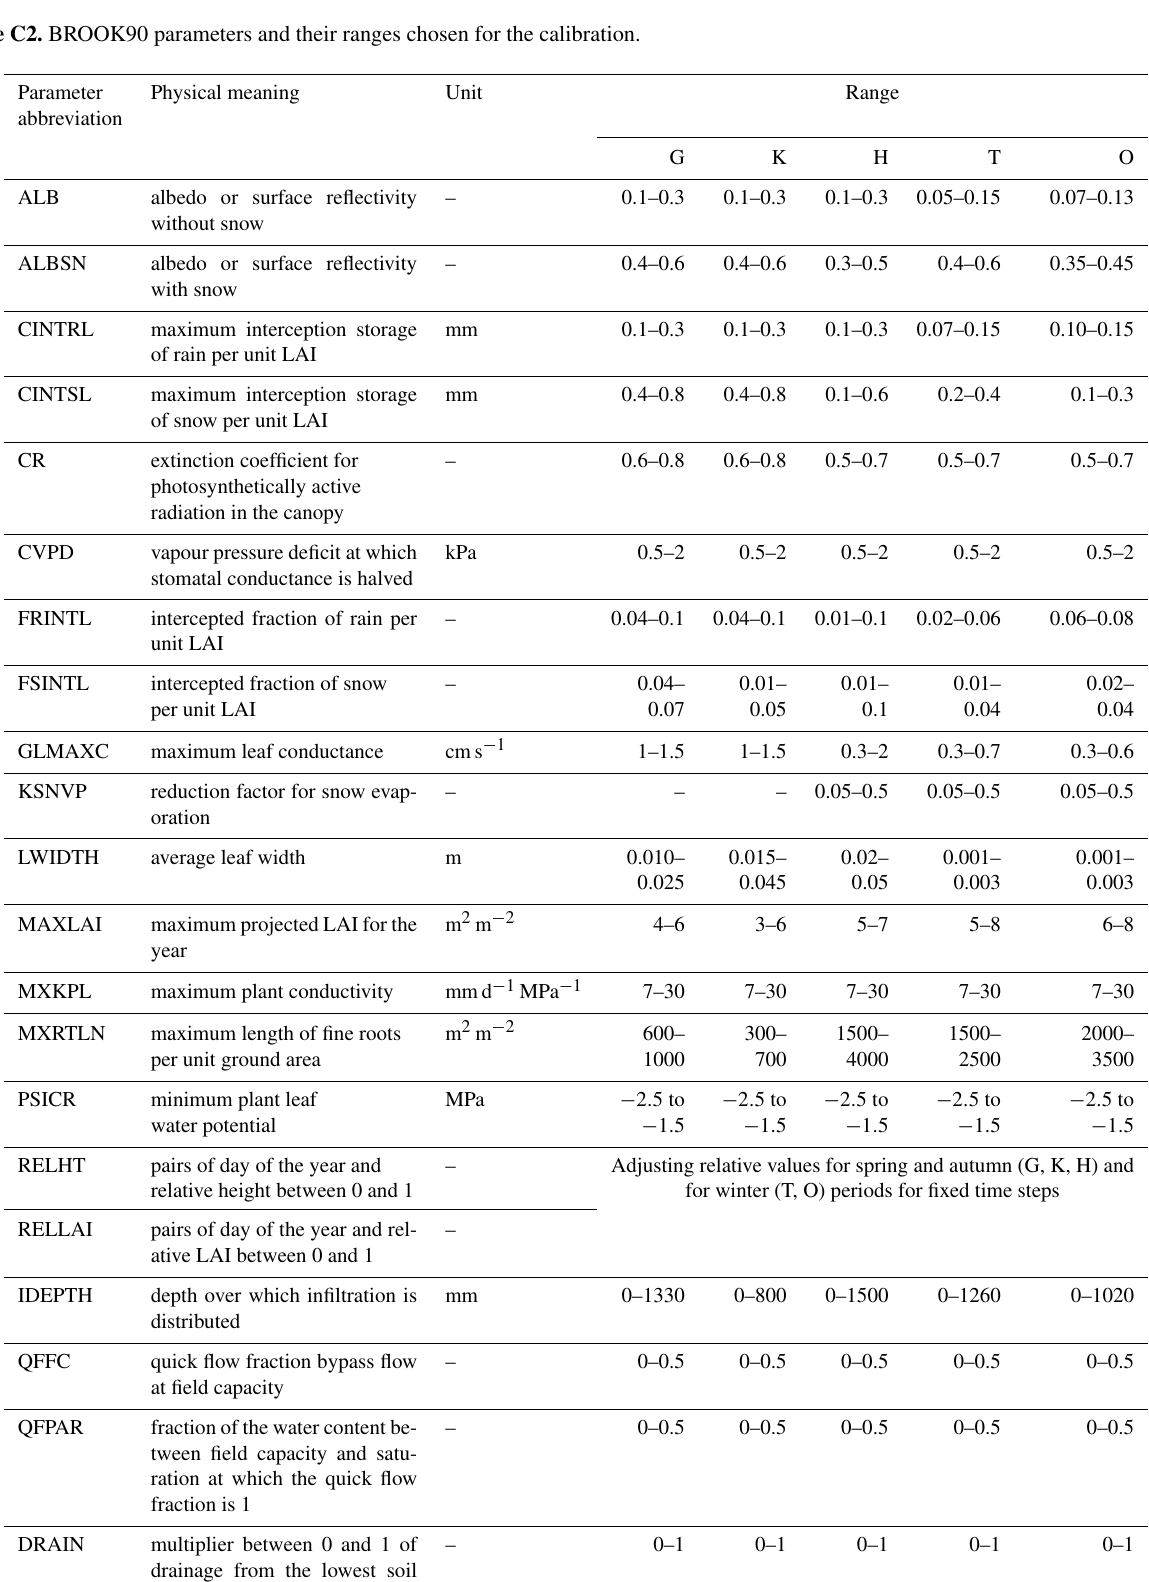
Table C2. BROOK90 parameters and their ranges chosen for the